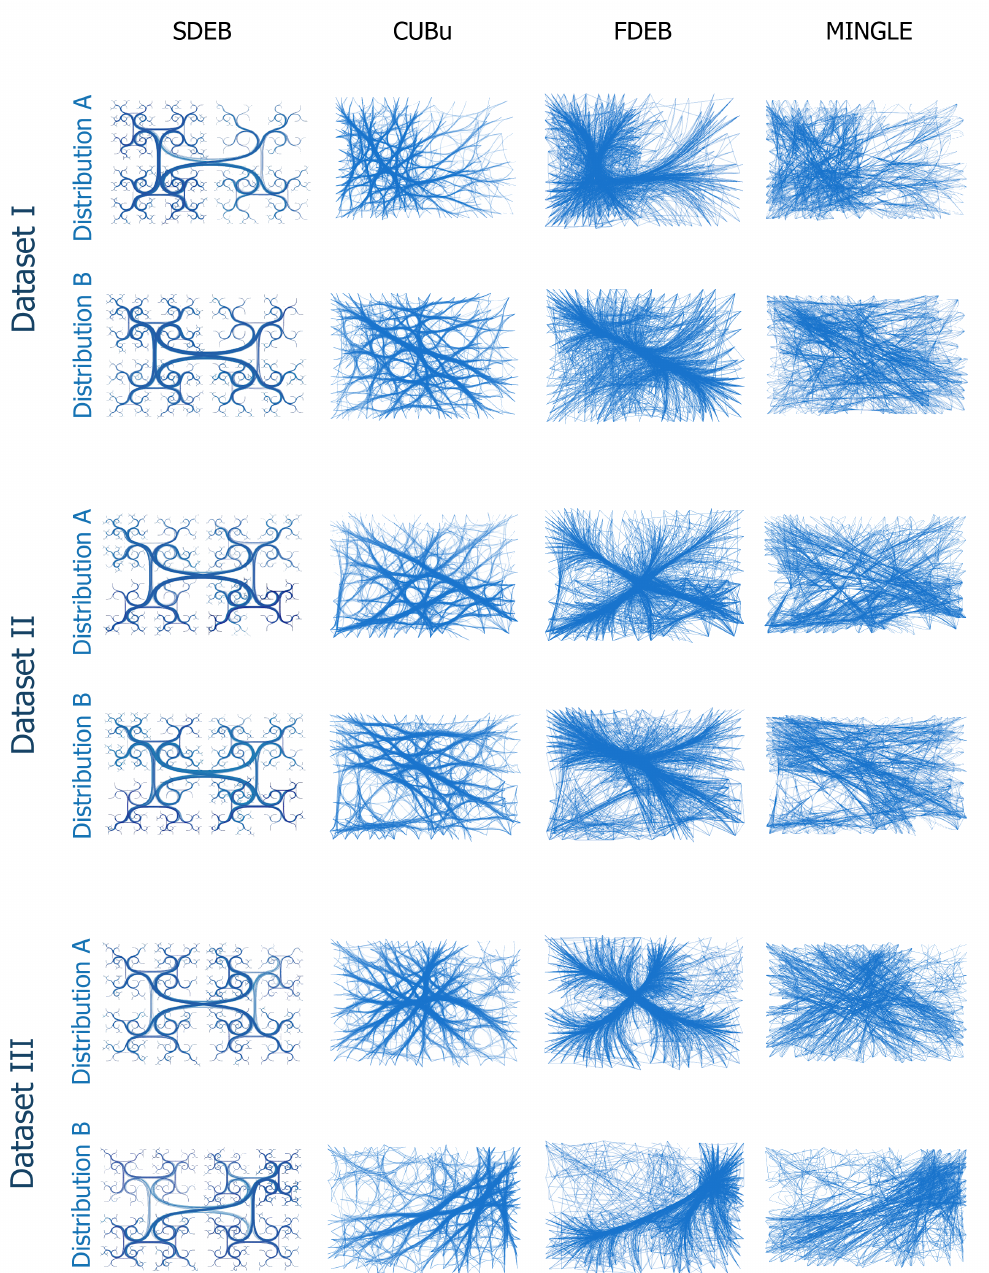
Figure 8. A comparison among the results attained by the SDEB, CUBu, FDEB, and MINGLE using the H-Tree layout. Even though the techniques share the same vertices position, the difference in bundling readability is evident. CUBu, FDEB, and MINGLE techniques generate the bundles only considering the spatially-similar edges trajectories, while our technique follows the H-Tree layout, producing more compact bundles and less cluttered